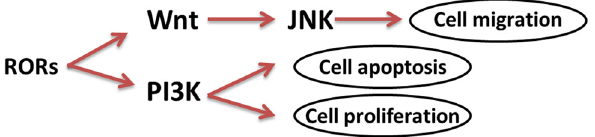
Figure 1: RORs ’ signaling